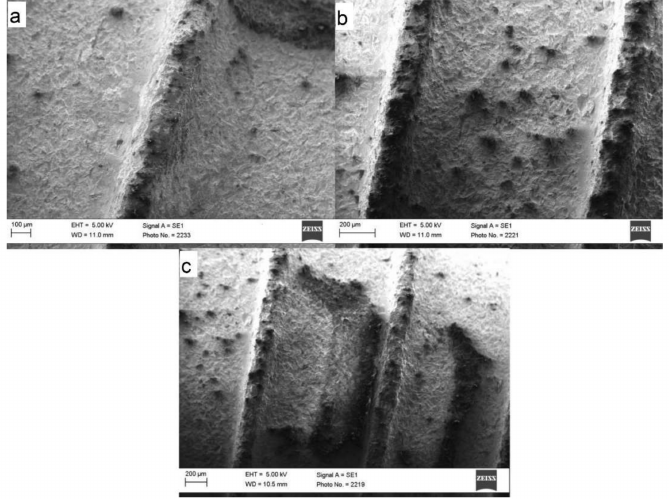
Figure 12. ( a ) The Roxolid ® shows surface roughness in isolated cases in the valley, on the flanks, and on the head. The unevenness appears somewhat more pronounced on the head. The valley seems to be plain. ( b ) The Roxolid ® could mostly maintain its surface topography at a level of 160 mJ. The changes in roughness and structural damage increased in the valley as well as at the flanks and the head. ( c ) At an energy level of 250 mJ, the surface properties of the implant could be significantly changed for the first time. At this energy, structural changes in the entire implant surface occurred. However, compared to the Standard Plus dental implants studied, the alterations at the surface were not